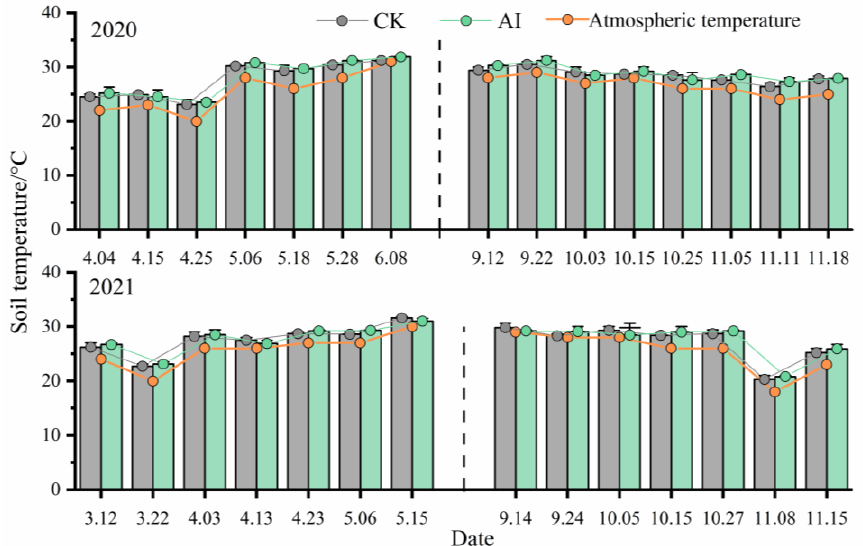
Figure 3. The dynamic change curve of soil temperature under different treatments (AI, aerated irrigation; CK, unaerated subsurface drip irrigation).